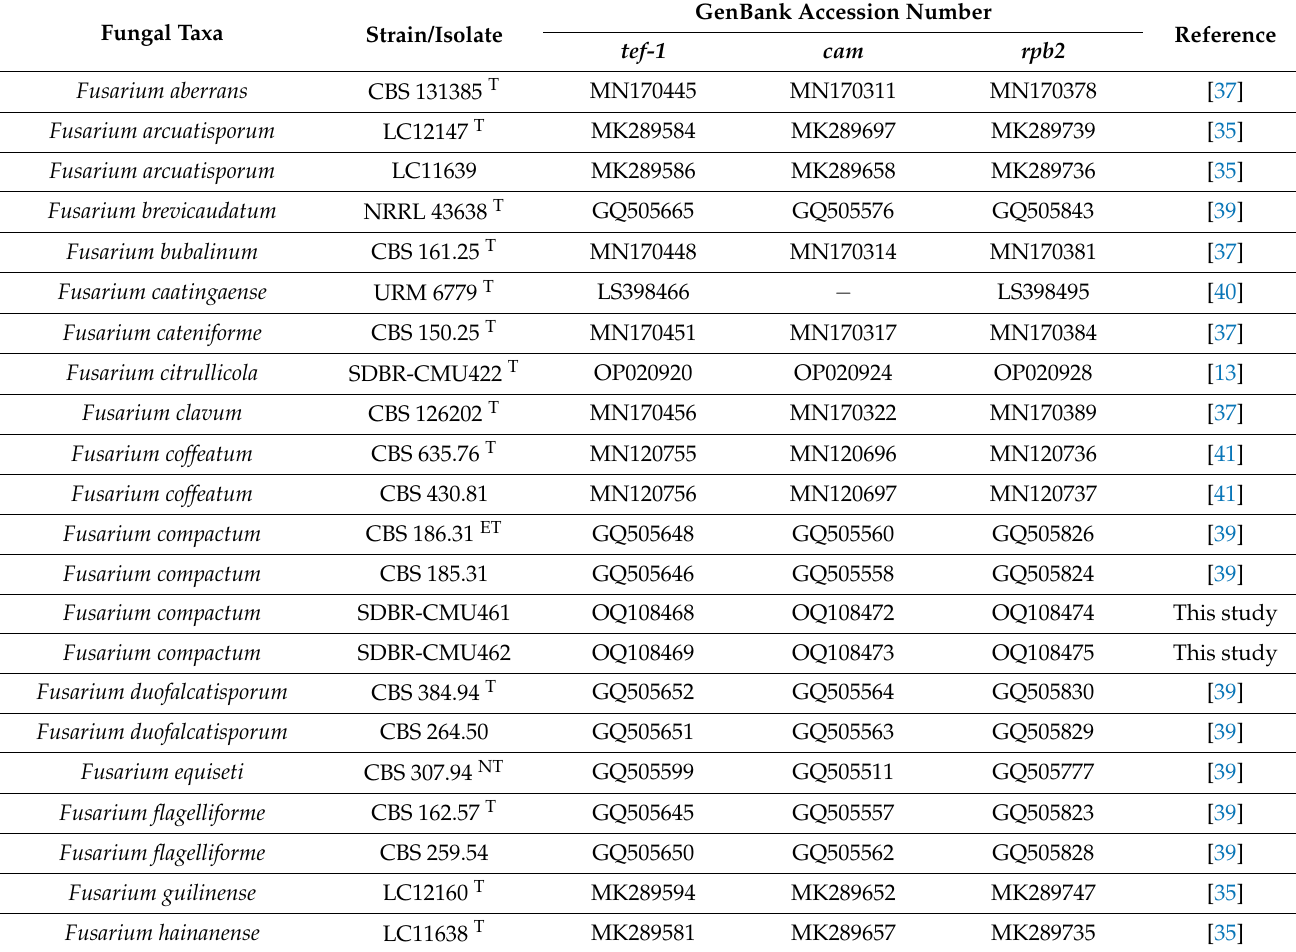
Table 1. Details of the Fusarium incarnatum-equiseti species complex sequences used in the molecular phylogenetic